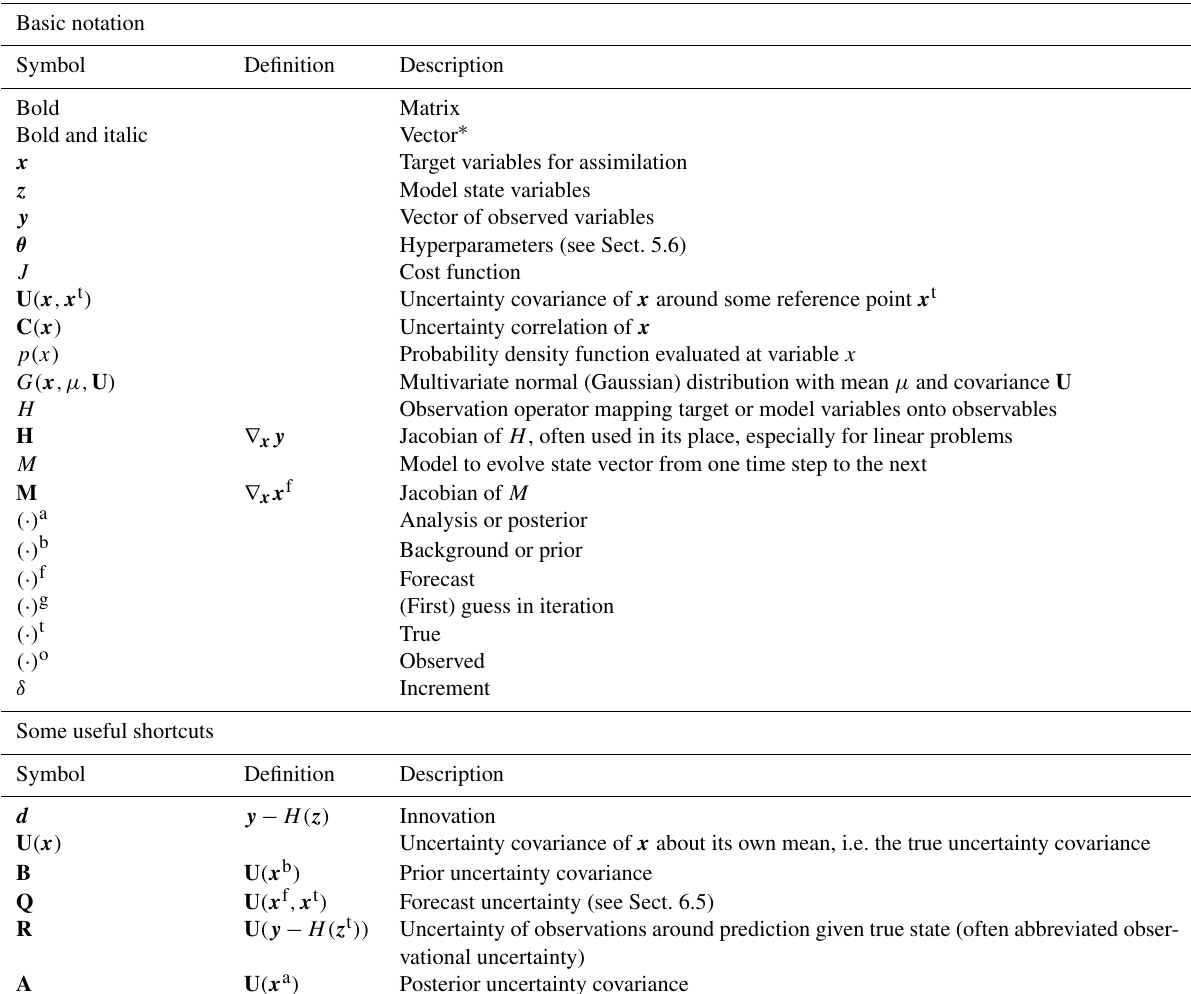
Table 1. Table of notation used throughout the issue. Borrows heavily from Ide et al. (1997) Appendix 1. Basic